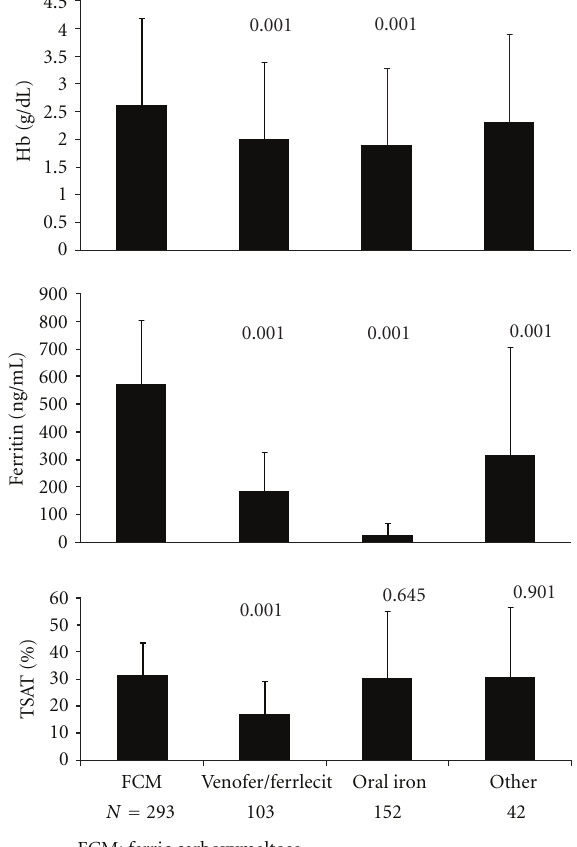
Figure 3: Mean changes in hemoglobin, ferritin, and TSAT from baseline to the highest value between baseline and end of study or time of intervention for subjects in the multidose study (mITT population). P values for the di ff erences between SMC groups versus FCM (determined by one-way ANOVA) are shown above the